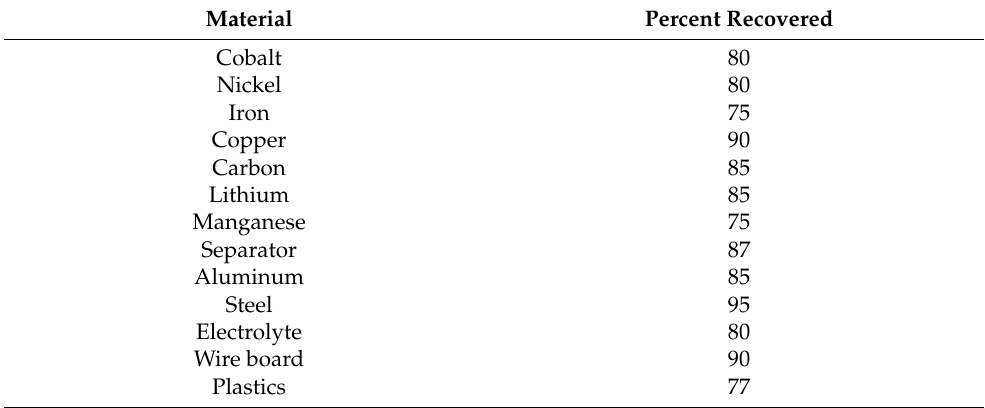
Table 2. Percentage of recycling [37–39].